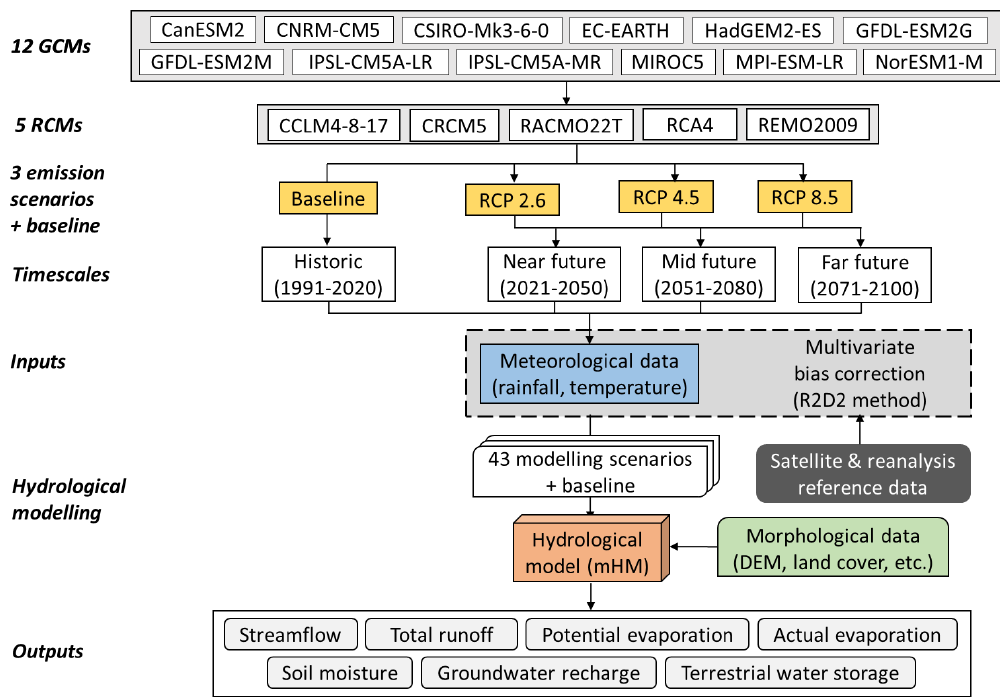
Figure 2. Overview of the procedure for assessing the impacts of climate change on hydrological processes.